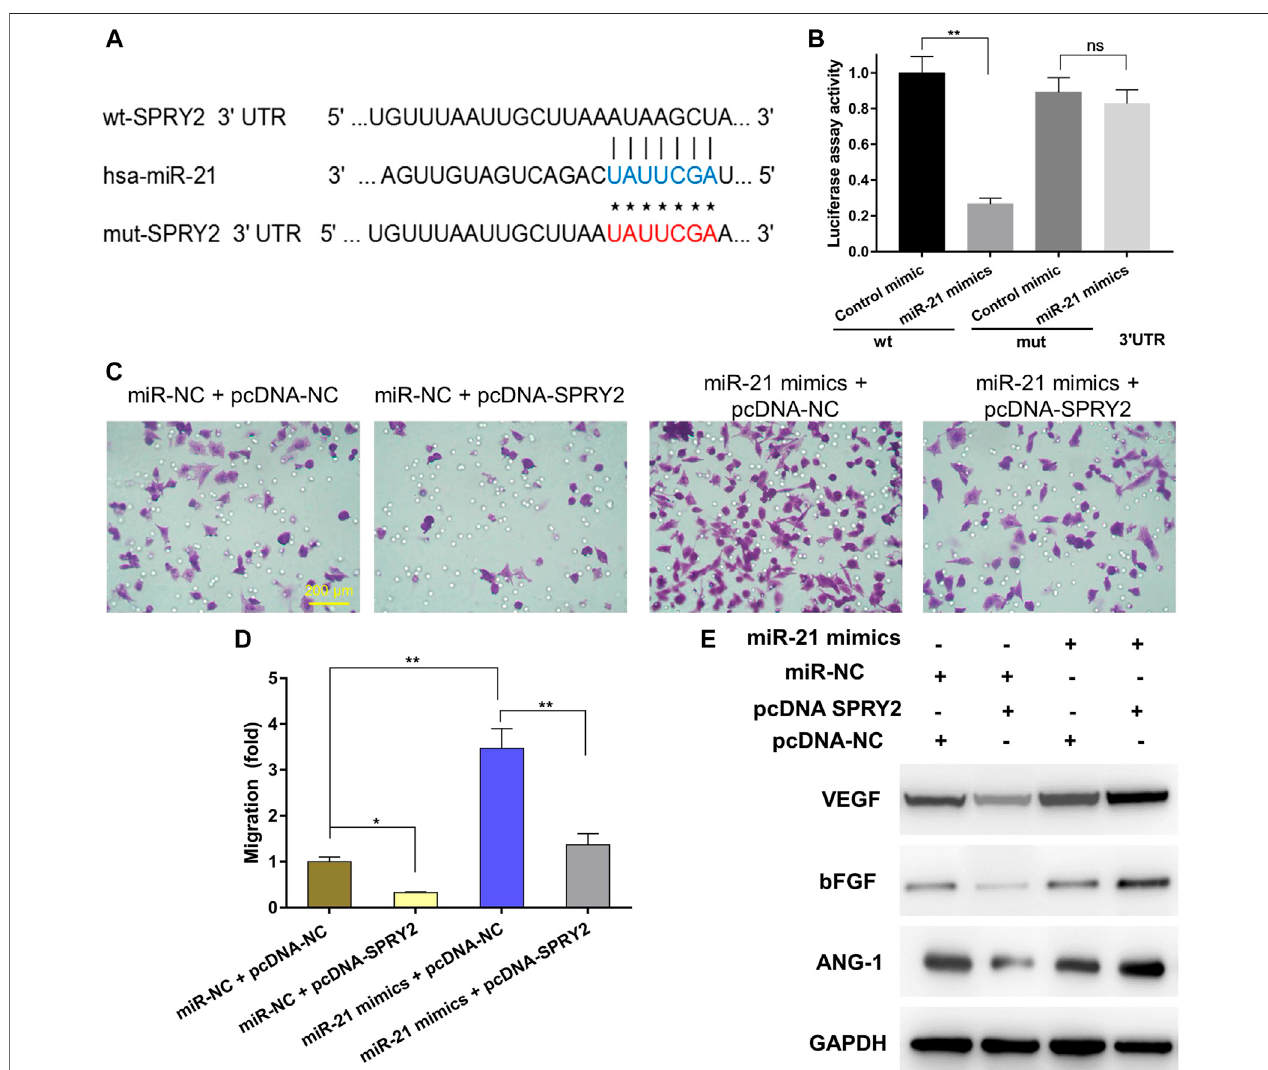
FIGURE 6 | Exosomal miR-21 promoted angiogenesis by targeting SPRY2 (*) p < 0.05 (**) p < 0.01, ns: no signi fi cant difference. wt, wild-type; mut, mutant; NC, negative control (A) The miR-21 binding sequence in the 3 ʹ -UTR of SPRY2 (B) The miR-21 mimics transfection reduced luciferase activity when compared to control mimics transfection, which con fi rms that SPRY2 are the target genes of miR-21 (C) The transwell assay showing the cell migration when HUVECs were co-transfected withmiR-21 mimics and pcDNA-SPRY2,and thequantitativeanalysis (D) indicatedoverexpressionofSPRY2suppressed theupregulation ofthemigrationrateof HUVECs by miR-21 mimics (E) Western blotting assays showing that overexpression of SPRY2 prevented the upregulation of VEGF, bFGF, and ANG-1 protein expression by miR-21 mimics.